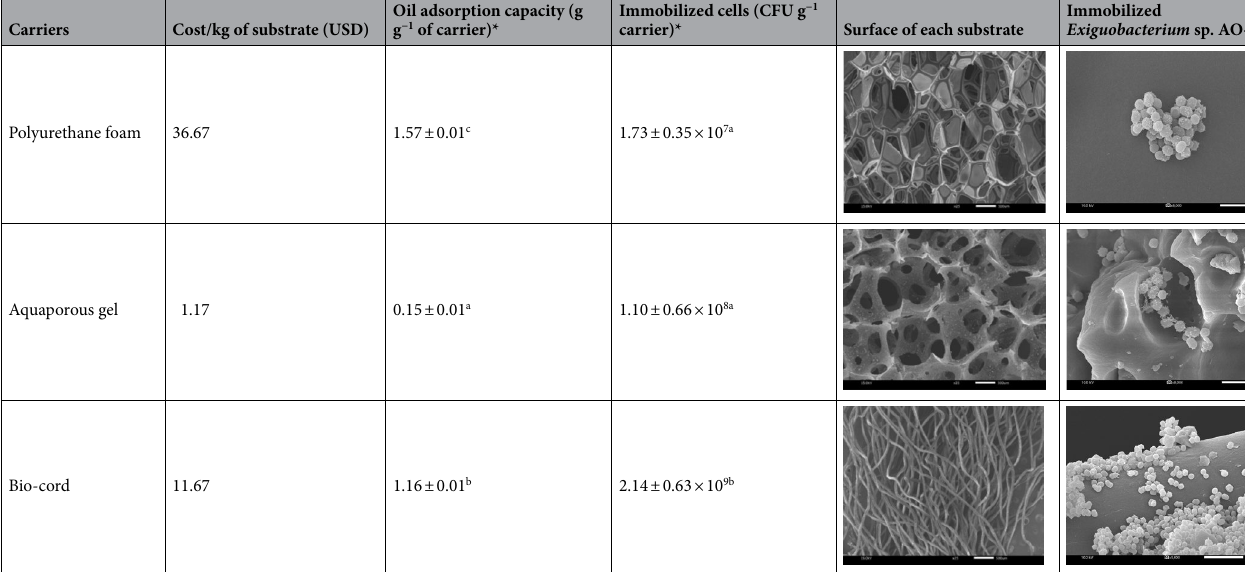
Table 1. Price, adsorption capacity, quantity of immobilized cells and characteristics of cells immobilized on carriers under scanning electron microscopy (SEM) separated by the type of carrier including polyurethane foam, aquaporous gel and bio-cord. *Values are expressed as the means ± sd. The values in each column with the same superscript letter are not significantly different by Duncan’s multiple range test ( P ≤